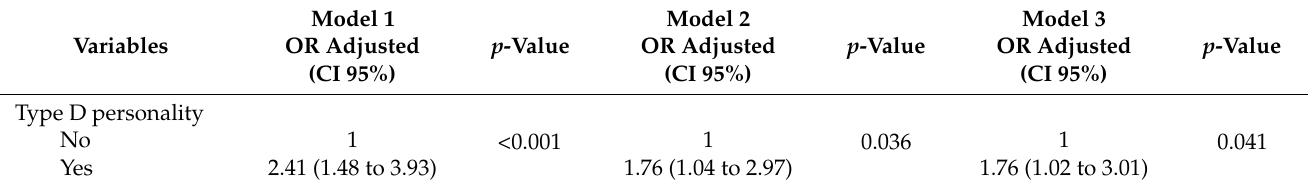
Table 3. Multivariate analyses ( n = 318).